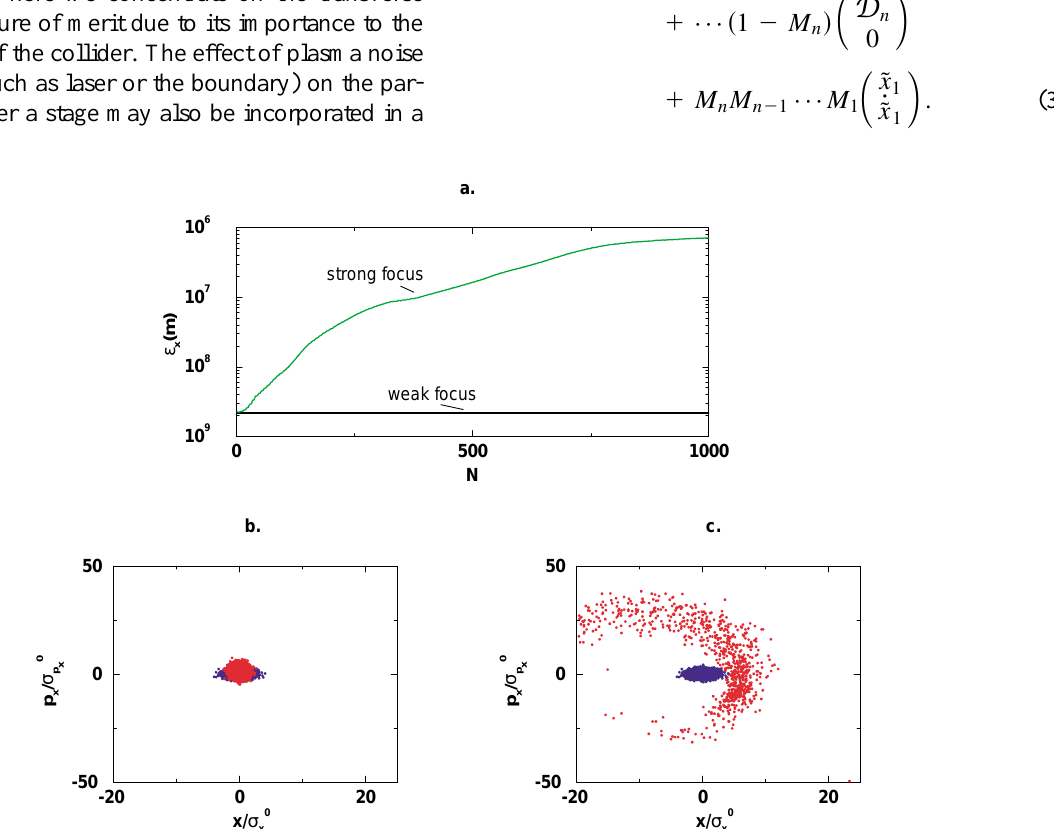
FIG. 3. (Color) Weak and strong focusing cases: (a) The normalized x emittance e x vs stage number N . The parameters used for the strong focus case were g p (cid:1) 100 , drift (cid:1) 17 cm, e 0 For the weak focus case see Sec. VI. (b) The phase space p x vs x for the weak focus case. (c) The strong focus case. The initial (in blue) distribution (Gaussian and the beam is assumed initially matched to the focusing properties of the channel) and the final (in red) after 1000 acceleration